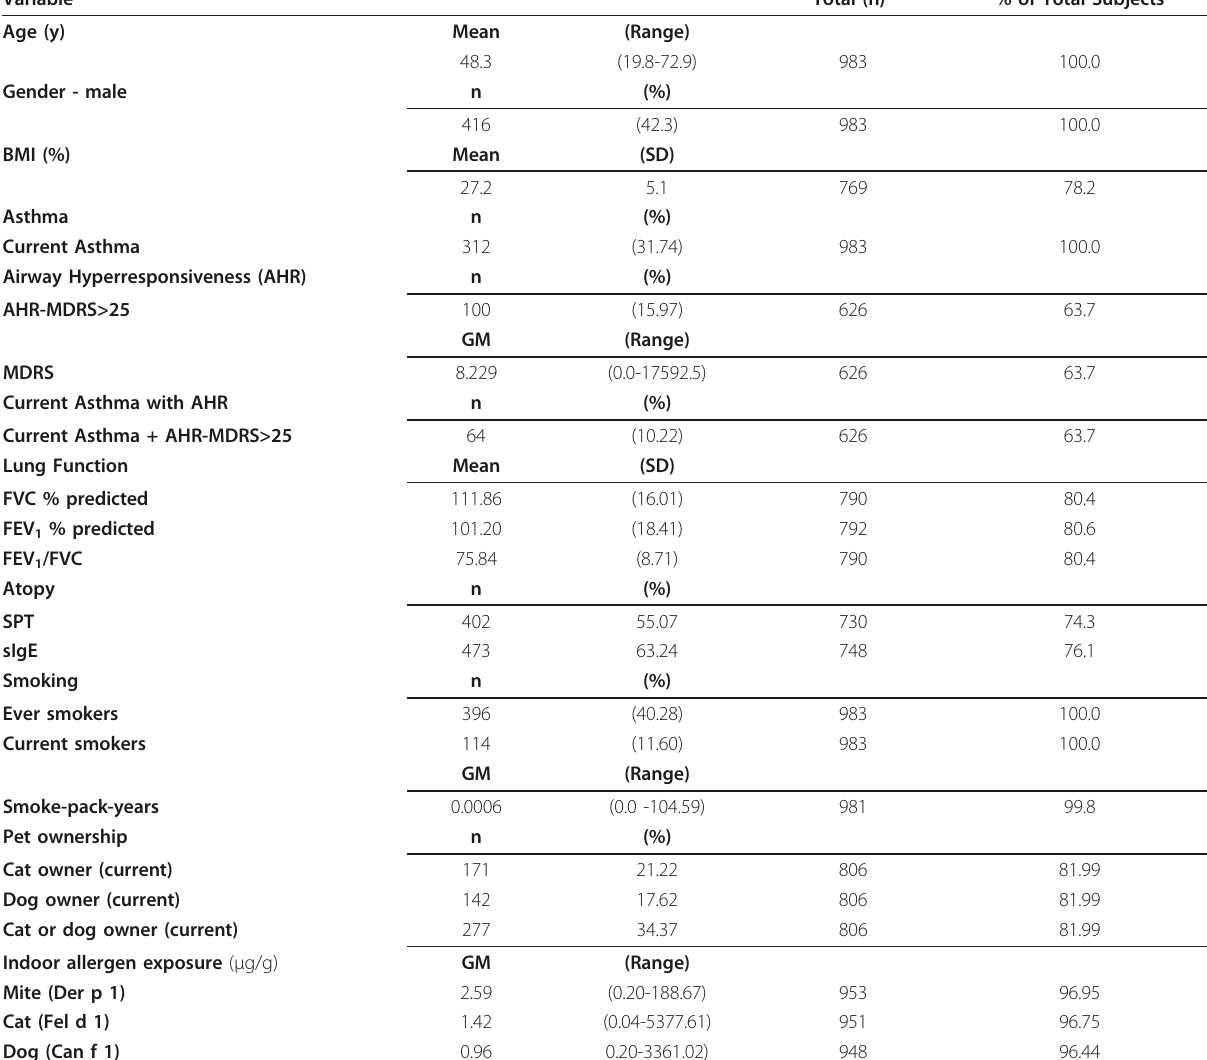
Table 1 Characteristics of the 983 subjects included in the study Variable Total (n)* % of Total